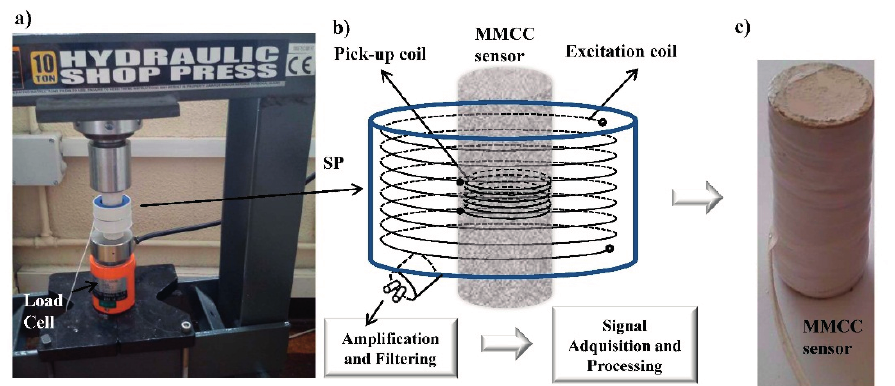
Figure 5. ( a ) Hydraulic press machine used to apply the mechanical compression